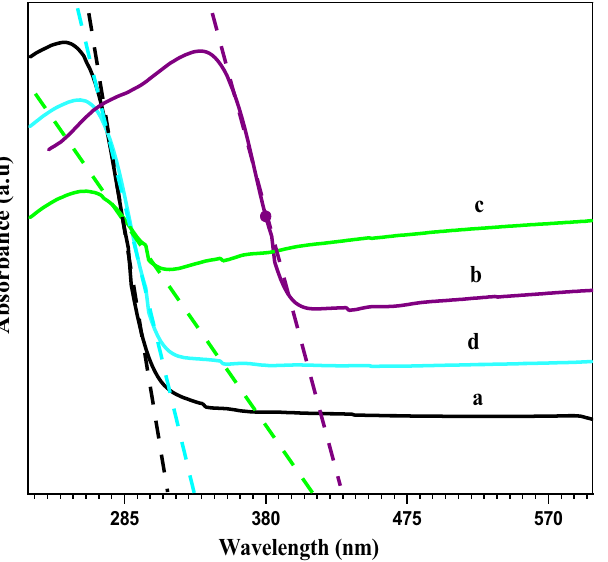
Figure 4. Band gab for ( a ) ZnO, ( b ) ZnO/5PVA, ( c ) ZnO/7PVA and ( d ) ZnO/10PVA calcined at 300